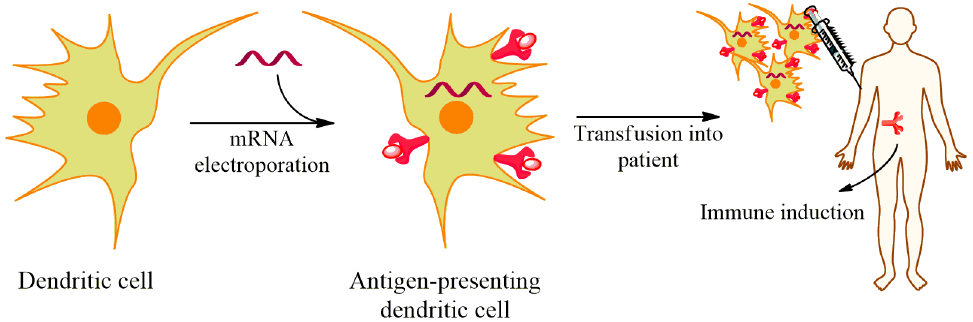
Figure 4. mRNA electroporation into the dendritic cell for vaccination process. mRNA transfection induces DC to present antigens, which then transfuse into the patient to establish immune de- fense.